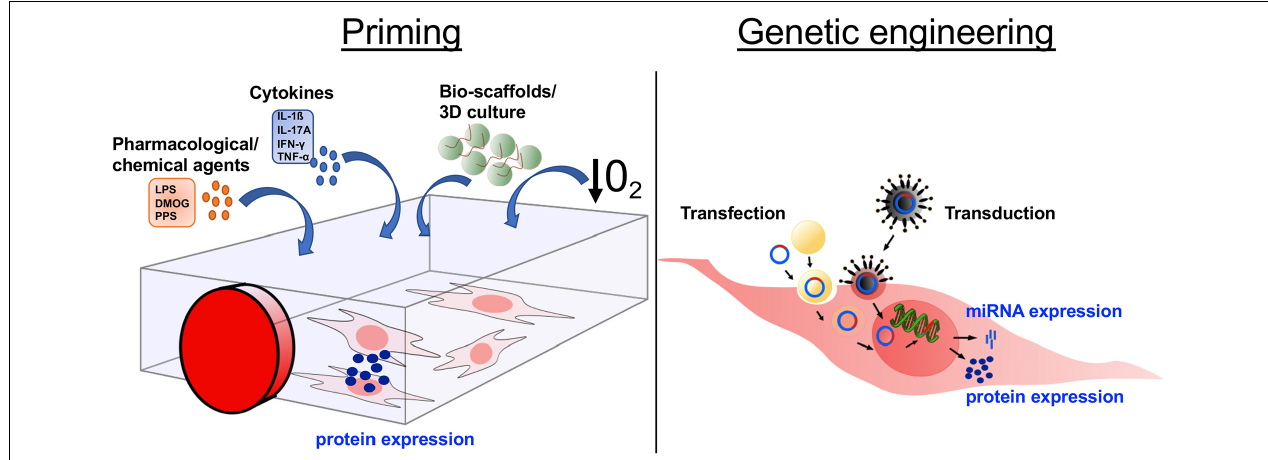
FIGURE 2 | Altering the mesenchymal stromal cell (MSC) secretome through in vitro manipulation. In order to increase the secretion of desired molecules, such as proteins or miRNA, MSCs are manipulated in culture through either priming or genetic engineering. The four main approaches of priming are (i) addition of pharmacological/chemical agents, (ii) treatment with cytokines, (iii) culture in 3D cultures/bio-scaffolds, and (iv) culture under induced hypoxic conditions. Genetic engineering is used to express/overexpress specific proteins or miRNA by a targeted RNA or DNA transfer into the MSCs via transduction, transfer by virus or viral vector, or transfection, transfer through various biological/chemical/physical approaches. DMOG, dimethyloxalylglycine; LPS, lipopolysaccharides; PPS, pentosan polysulfate; IL, interleukin; IFN, interferon; TNF, tumor necrosis factor; 3D, 3-dimensional; O 2 ,